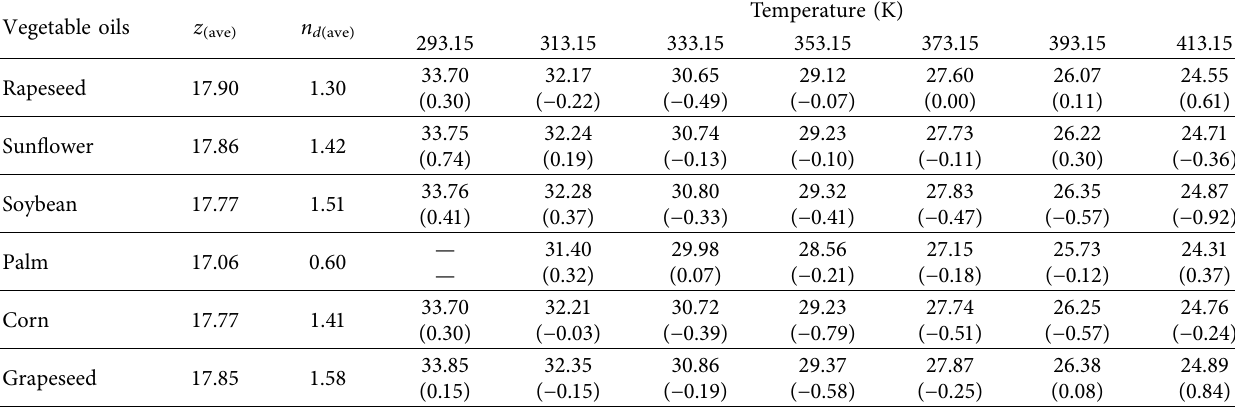
Table 3: Te predicted surface tension of the proposed model compared in the case of 6 vegetable oils at 293.15–413.15K. Vegetable oils z (ave) n d (ave)